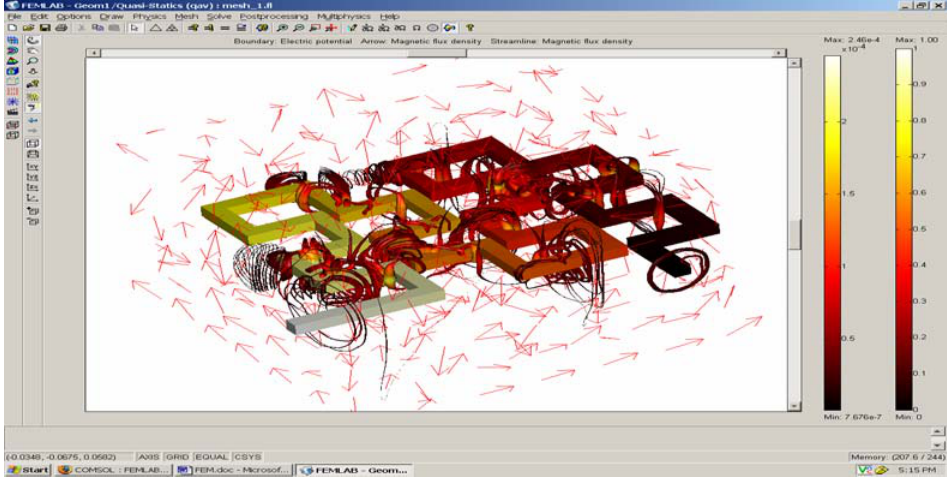
Figure 14: Solution of mesh type